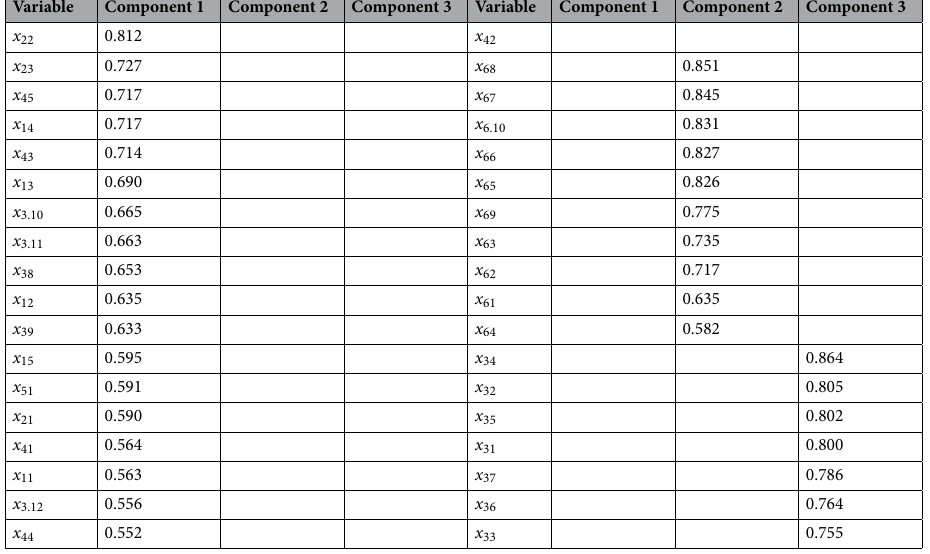
Table 7. Rotated component matrix.